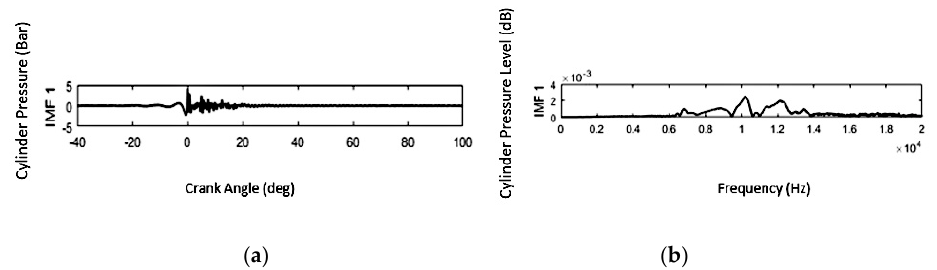
7 of 26 Figure 3. Time-frequency distribution (TFD) of the high-frequency in-cylinder pressure oscillation under 1400 r/min full load condition. Firstly, the original cylinder pressure signal of 1400 r/min full load is decomposed by EEMD, the ensemble time is set as 100, the results of angle domain and frequency domain are shown in Figure 4a,b, respectively. It is clear that the high-frequency oscillation components highlighted in Figure 3 cannot be extracted effectively by the EEMD method. This is because uniform spline approximation is used as a filter in the EEMD method, which is not completely adaptive, resulting in modal aliasing. ( a ) ( b ) Figure 4. Decomposed results of the in-cylinder pressure under 1400 r/min full load condition by ensemble empirical mode decomposition (EEMD): ( a ) angle domain results; ( b ) frequency domain results.